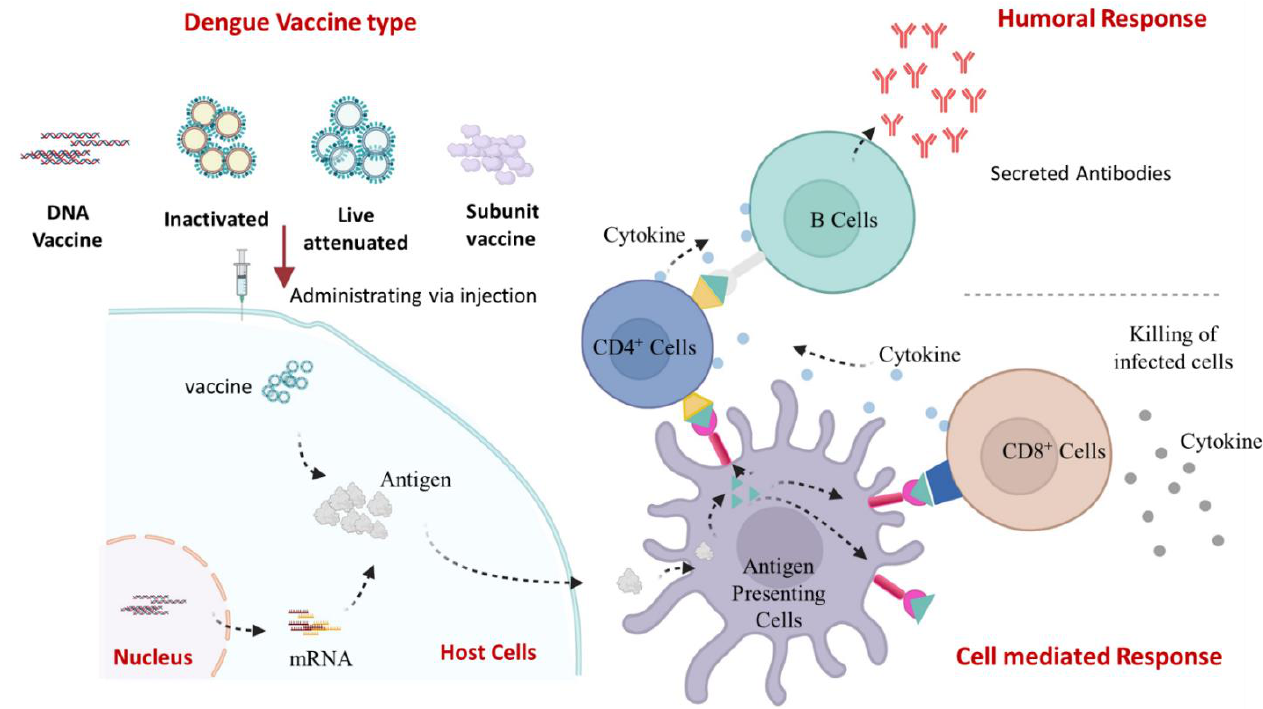
Figure 6. Therapeutic mechanism of a dengue vaccine: Vaccine was administered subcutaneously, and antigen-presenting cells (APC) present the processed antigen, which stimulates T lymphocytes. T lymphocytes promote the development of B cells. The maturation of the antibody response occurs because of B-cell proliferation, which is dependent on the T cells. Neutralizing antibodies (Nabs) specific for the dengue vaccine are secreted preferentially by plasma cells. Activated CD8 T cells can mount a response against infection by secreting cytokines and killing off viral infected cells.